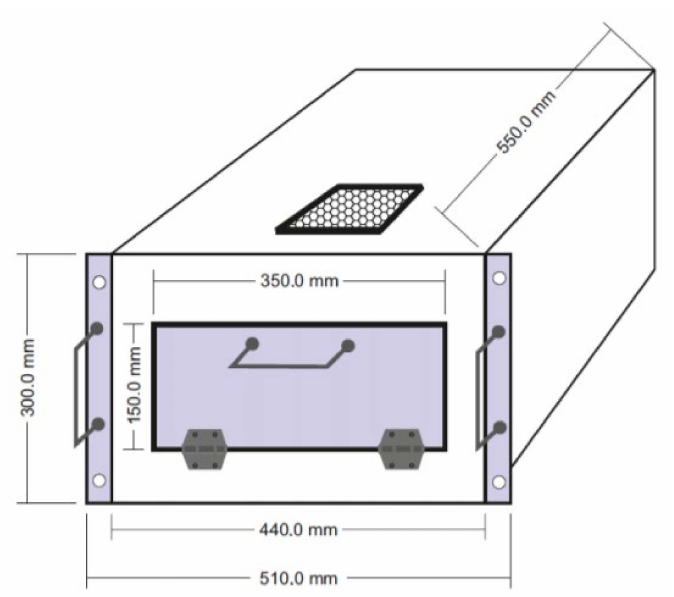
Figure 8. Shielding enclosure